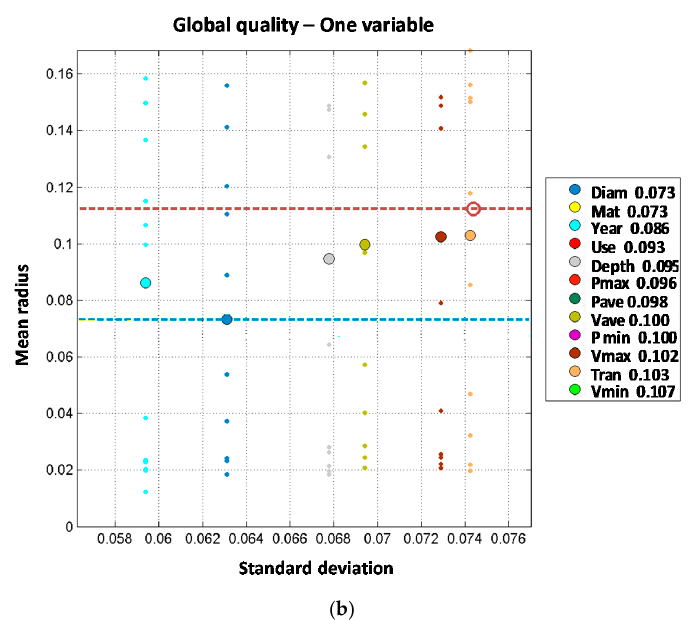
Figure 3. First order models results based on mean radius and standard deviation: ( a ) distribution lines; and ( b ) trunk mains. Individual validation models are represented as small dots and average value for the model is represented as a large dot (in the same color). The legend presents the numerical values of mean radius obtained for each model. Order zero mean radius is represented by the brown dashed line and the best predictive model is represented as a blue dashed line.